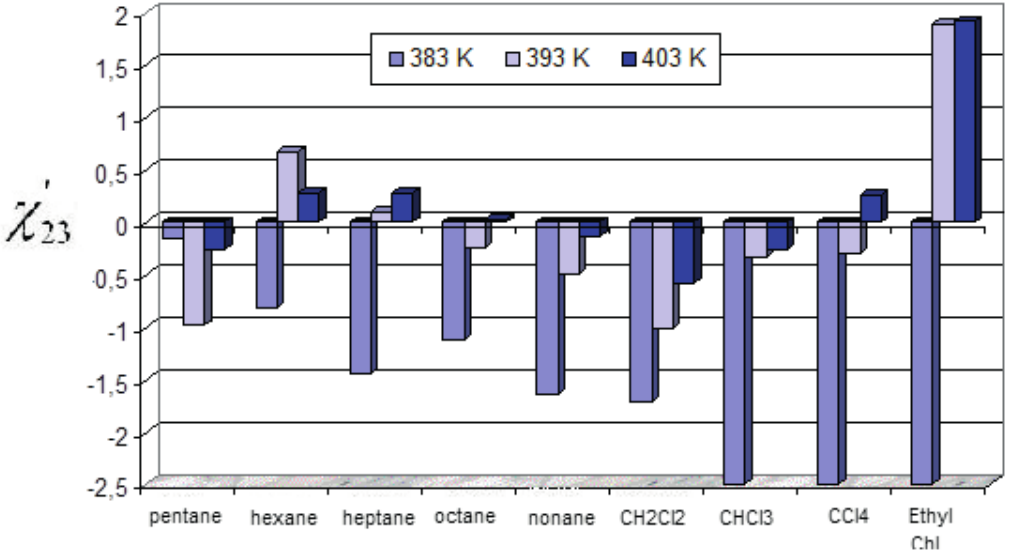
Figure 3: Effects of test solutes on χ